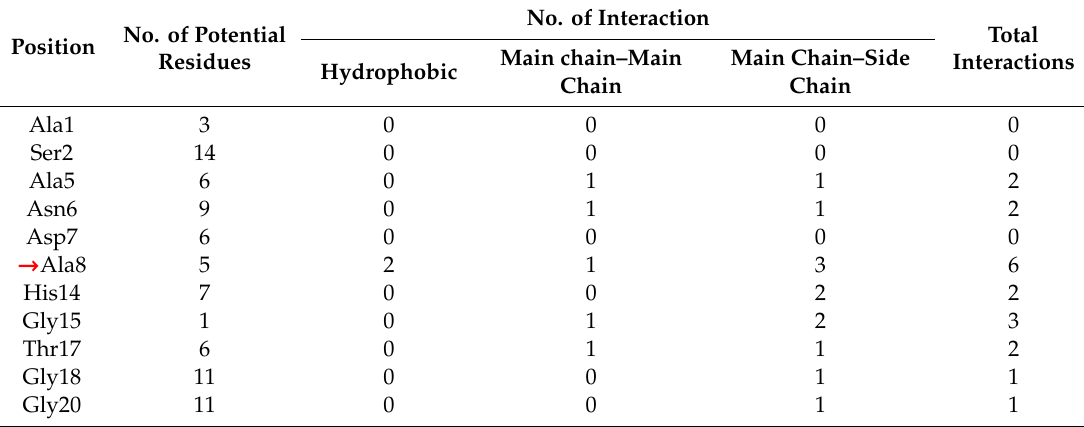
Table 1. The number of hydrophobic, main chain-main chain and main chain–side chain interactions at the 11 potential critical points.